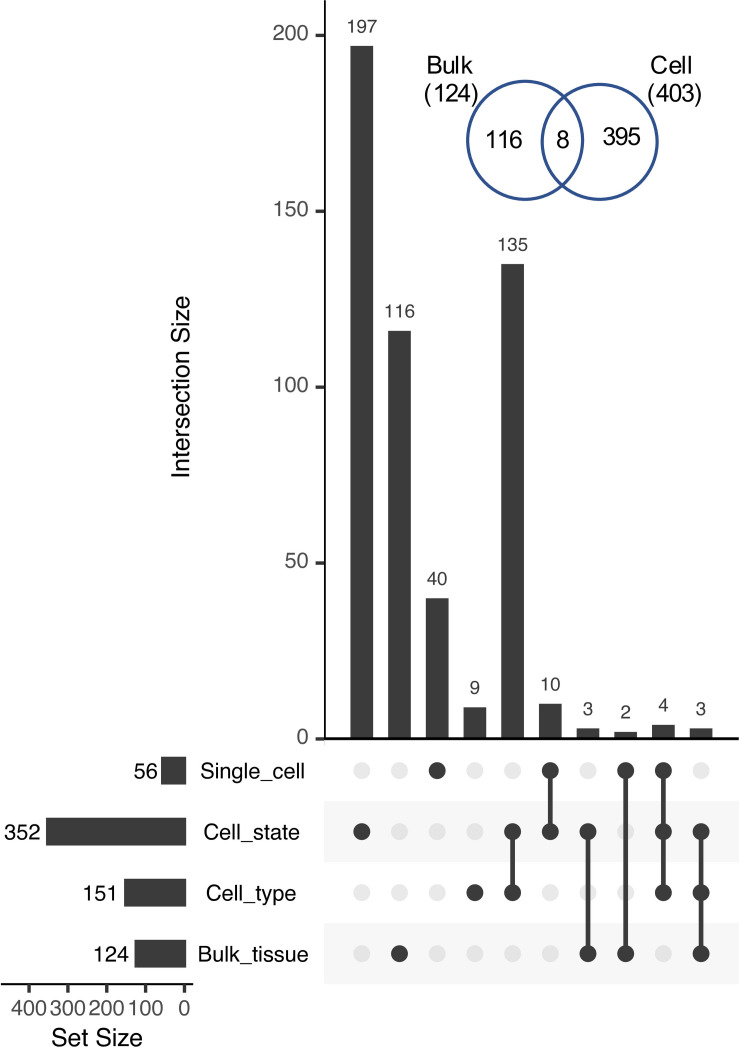
UpSet plot of intersections among Class 4 genes identified at different levels of organization. Inset, Venn diagram showing the overlap between Class 4 pairs identified in bulk tissue (Bulk) vs. those identified at sub-tissue levels (Cell; including cell type, cell state, and single cells).